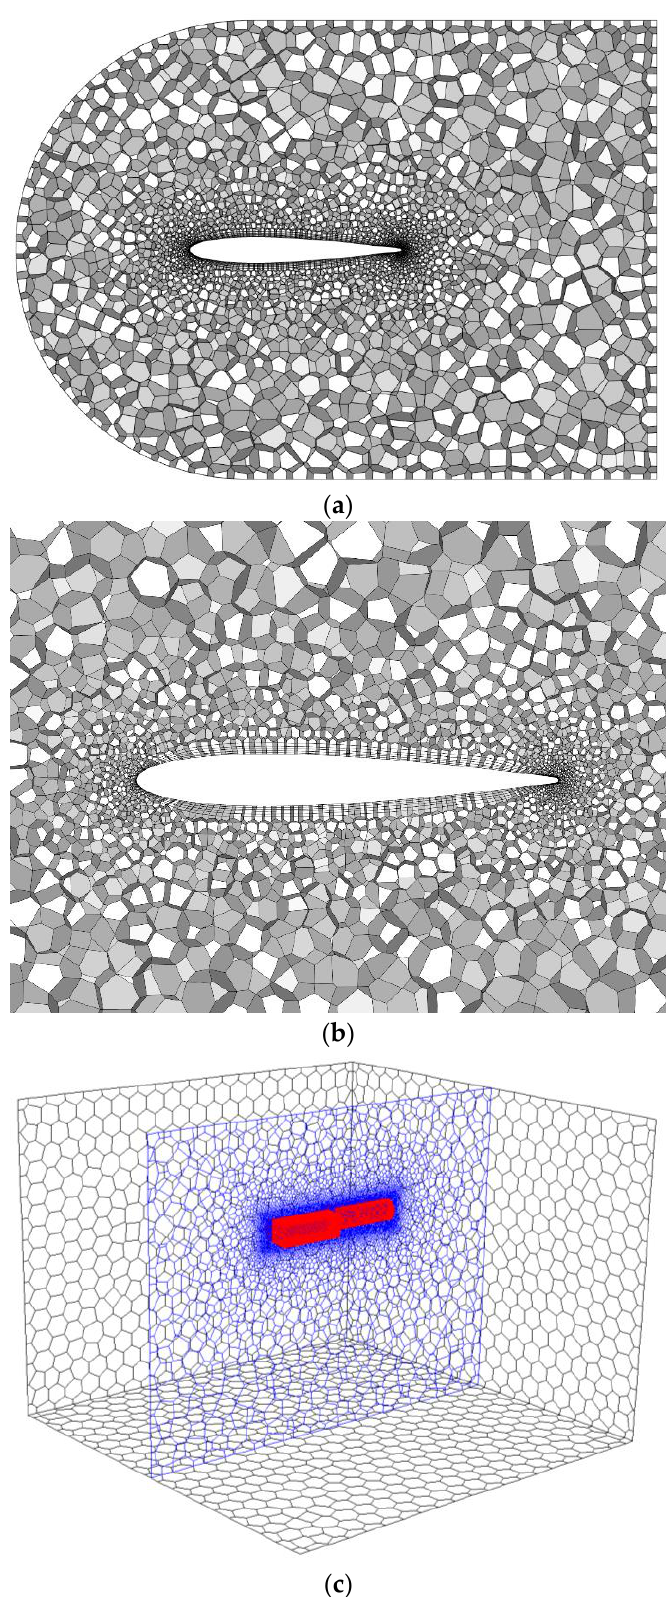
Figure 2. Blade motion nested mesh. ( a ) Grid section of the foreground area. ( b ) The boundary layer region of the foreground grid section. ( c ) Assembly system of the nested grid.